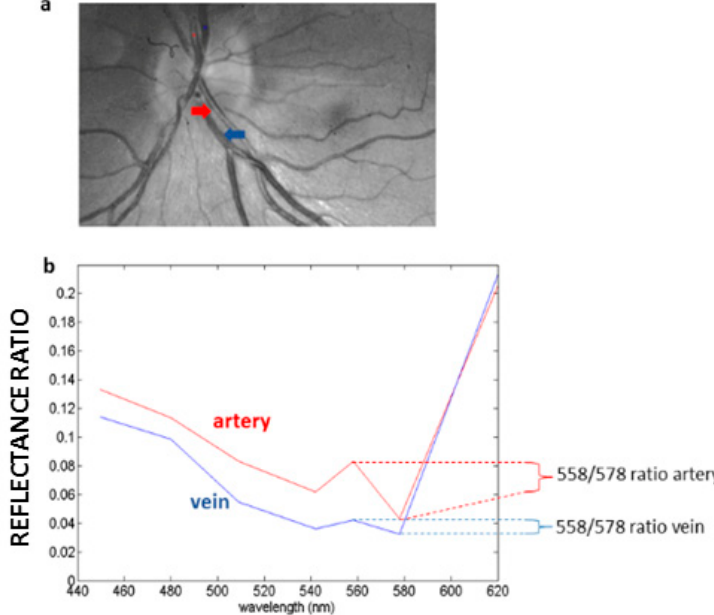
Figure 6. Reflectance spectra of artery and vein: ( a ) multispectral image of the peripapillary region showing an artery (red) and a vein (blue), selected for reflectance measurements, ( b ) reflectance measurements in the artery and vein. The 558/578 ratio represents the reflectance measured at 558 nm corresponding to the trough absorbance of HbO 2 and at 578 nm corresponding to the peak absorbance of HbO 2 ; the artery shows a higher 558 / 578 ratio which means that the contribution of HbO 2 is higher than the contribution of HbR, attesting to the validation of retinal